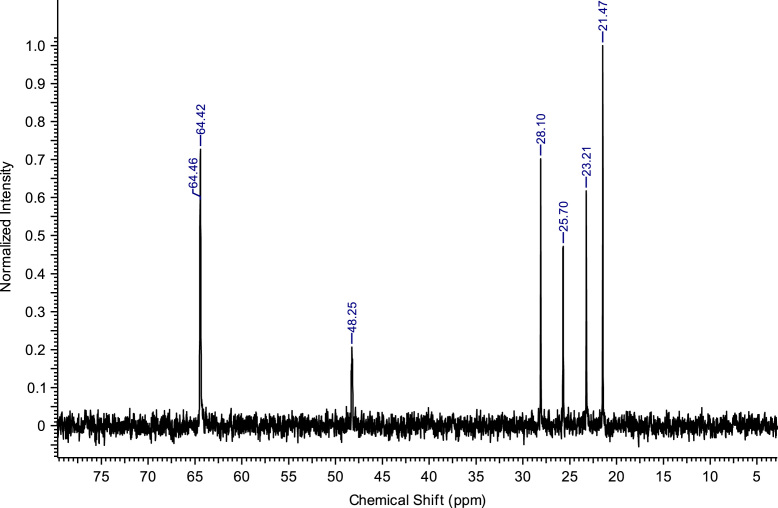
13C NMR spectra of C8(MPyrr)2Br2.